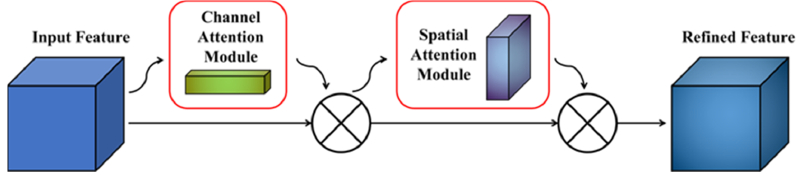
Figure 2. CBAM algorithm implementation flowchart.